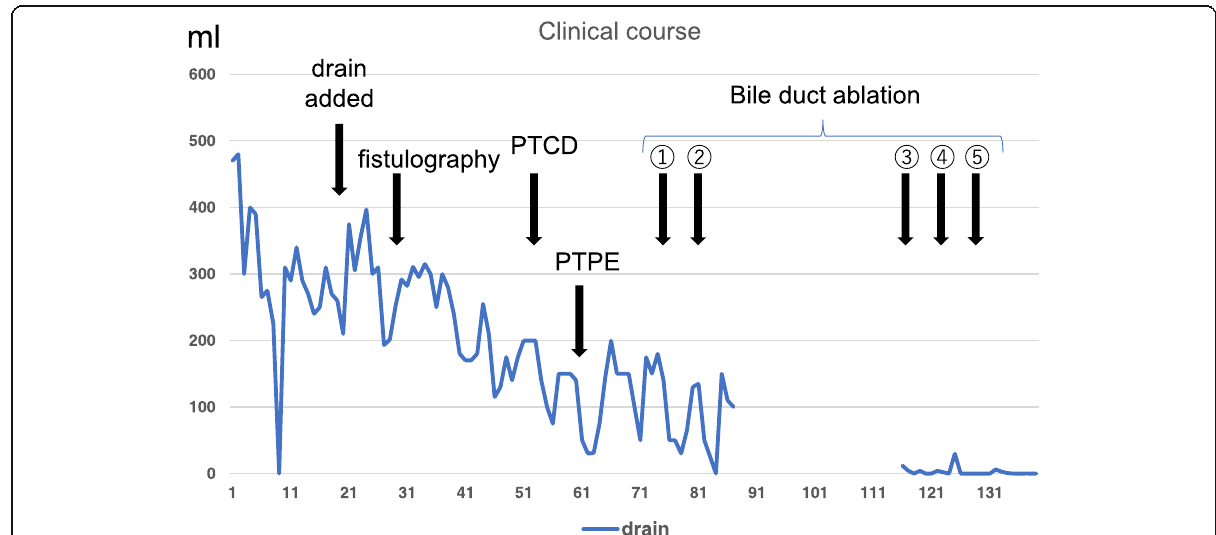
Fig. 3 Clinical course of bile duct leakage and drainage amount. The number shows the times of bile duct ablation. PTCD: percutaneous transhepatic cholangiography drainage. PTPE: percutaneous transhepatic portal